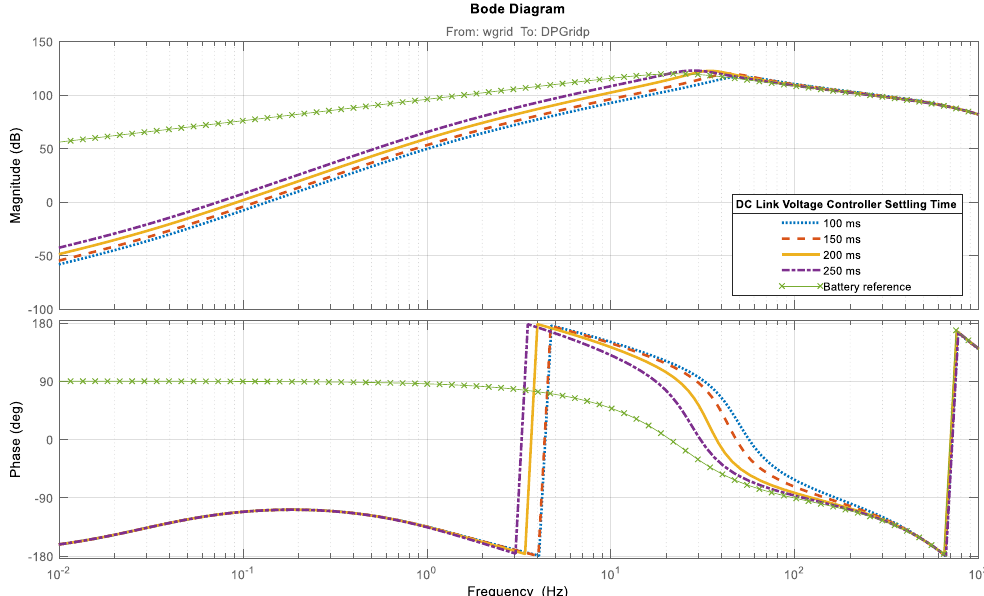
Figure 21. Bode plots showing the effect of the DC link controller bandwidth on the PVCCI frequency response.